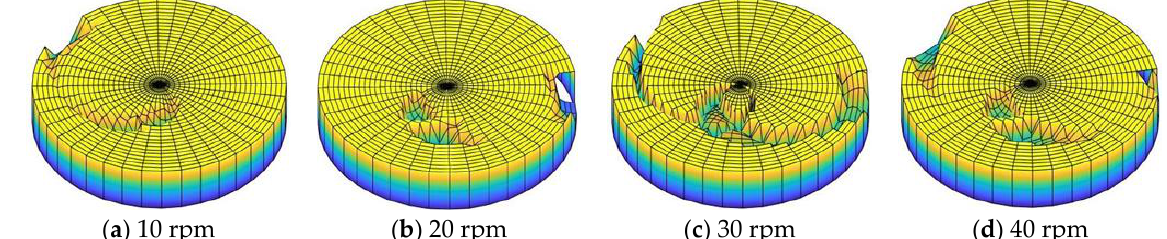
Figure 27. Scratch damage morphology on the workpiece surface with different magnetic field speeds.